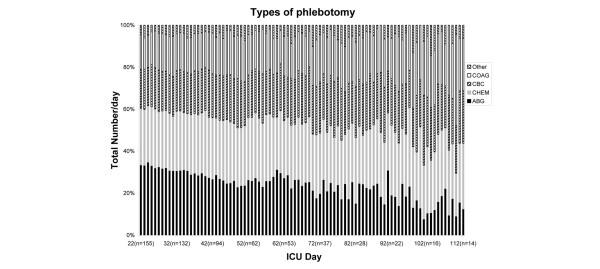
Types of phlebotomy over time. Figures in parenthesis on the x-axis denote the number of patients. ABG, arterial blood gas; CBC, complete blood count; CHEM, chemistry; COAG, coagulation; Other, blood cultures and others.